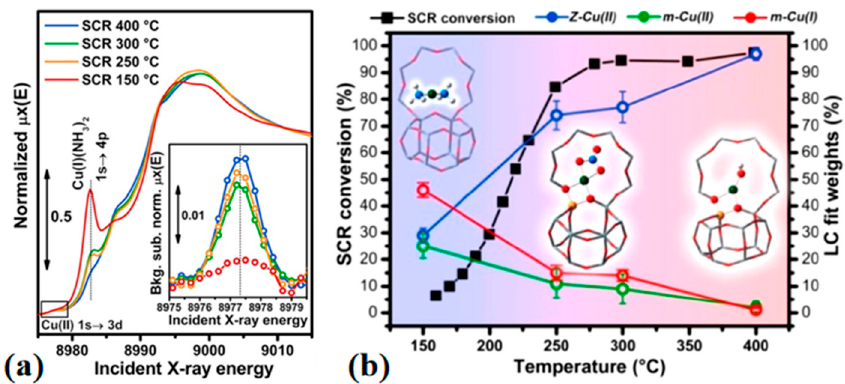
Figure 5. ( a ) Operando XANES collected during SCR at temperatures of 150, 250, 300, and 400 °C and ( b ) comparison between temperature-dependent NH 3 -SCR conversion rate and Cu-speciation in Cu-CHA: structural snapshots of the dominant (highest relative abundance over the total number of Cu sites) model Cu species evidenced by linear combination fitting (LCF) analysis of operando XANES for each probed temperature are also reported. Reproduced with permission from [84], copyright American Chemical Society, 2016.